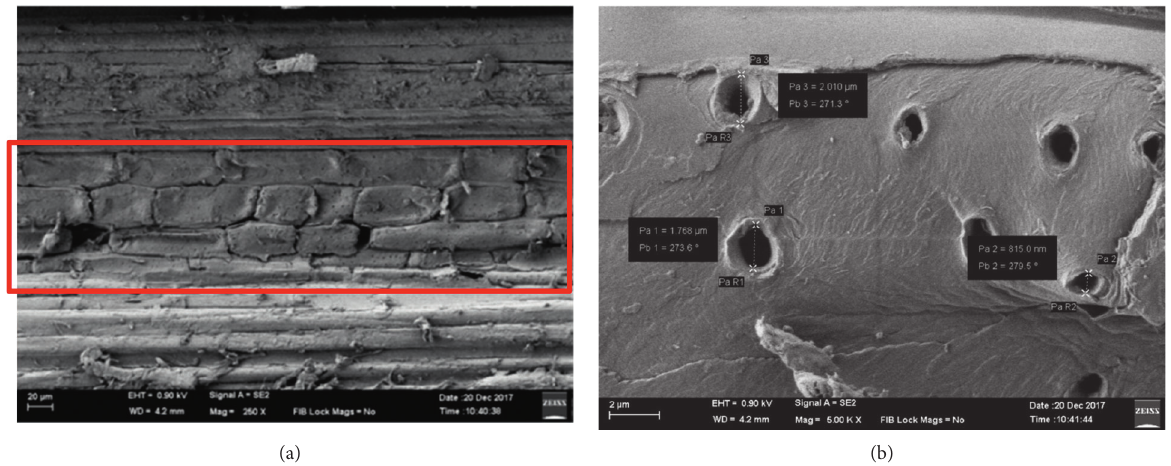
Figure 10: (a) Spongy structure in bamboo. (b) Closer view of spongy structure in